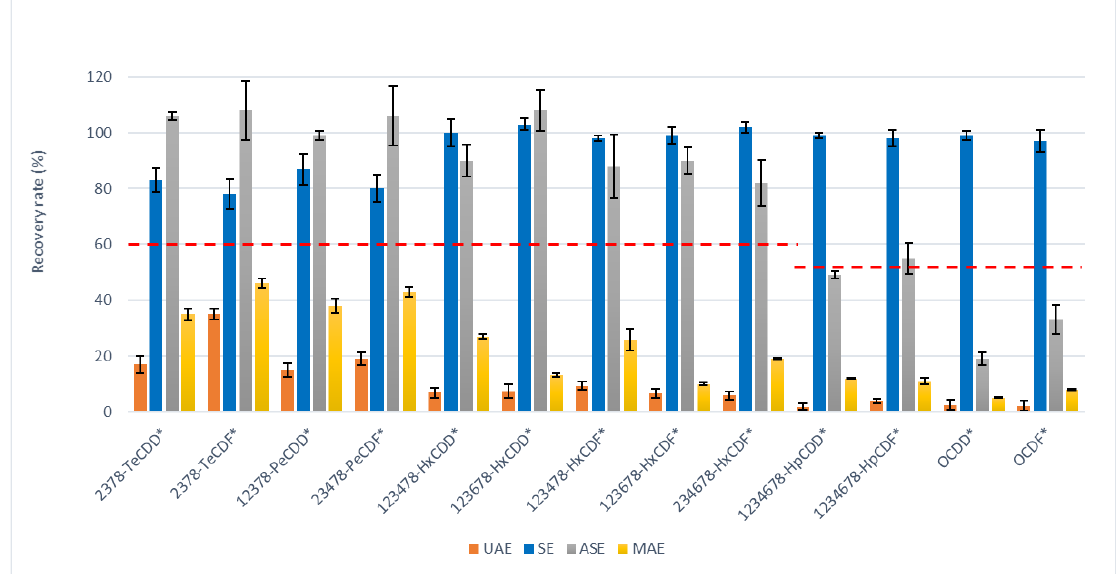
Figure 2. Recovery rates (%) and standard deviation of 13 C-PCDD/Fs (labeled with “*”) by ultrasonic assisted (UAE), Soxhlet (SE), accelerated solvent (ASE), and Microwave assisted (MAE) extractions. Each procedure was performed in triplicate. The dashed red line is the minimum acceptable recovery rate (ISO16000-14).